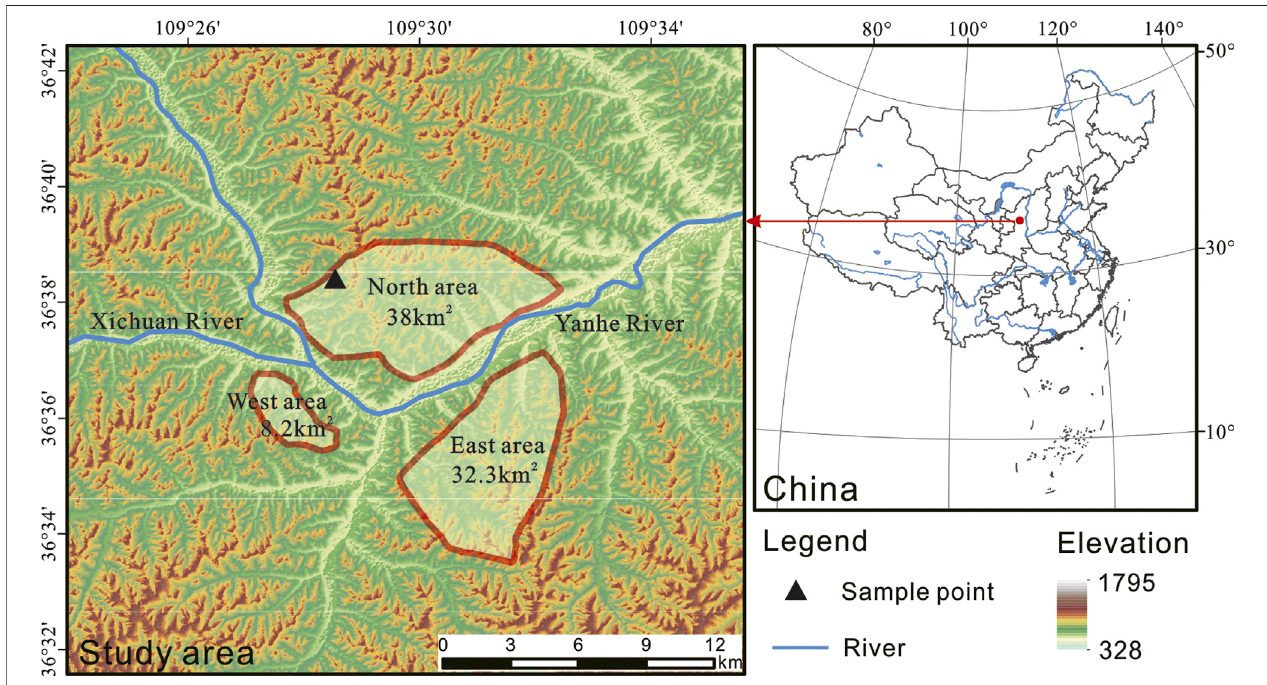
FIGURE 1 | Study area and location of soil